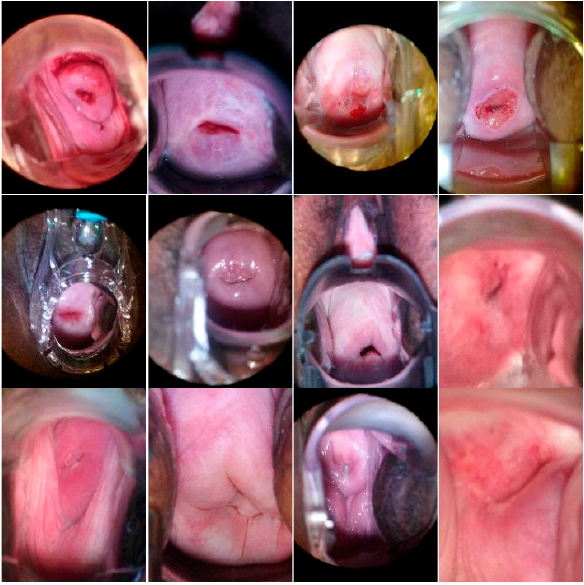
Figure 2. Example images from Kaggle [6] showing cervix images of different types. Type 1 is on the top row, while Types 2 and 3 are on the middle and bottom rows, respectively.